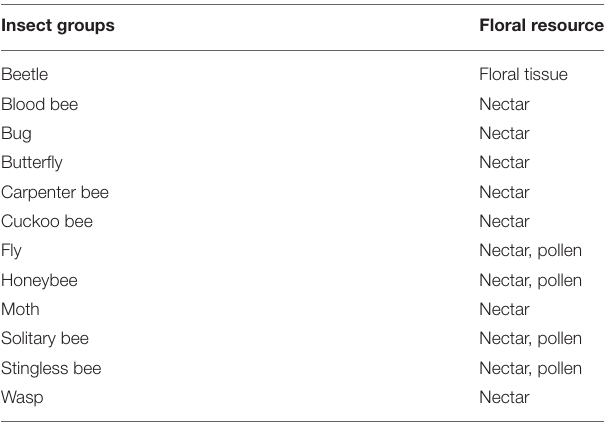
TABLE 3 | Floral resources collected from fennel by different insect